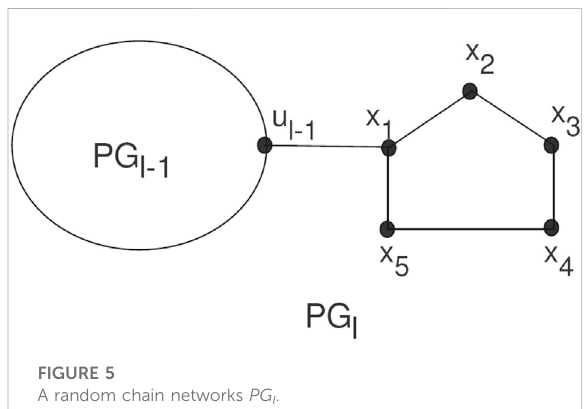
FIGURE 5 A random chain networks PG l .